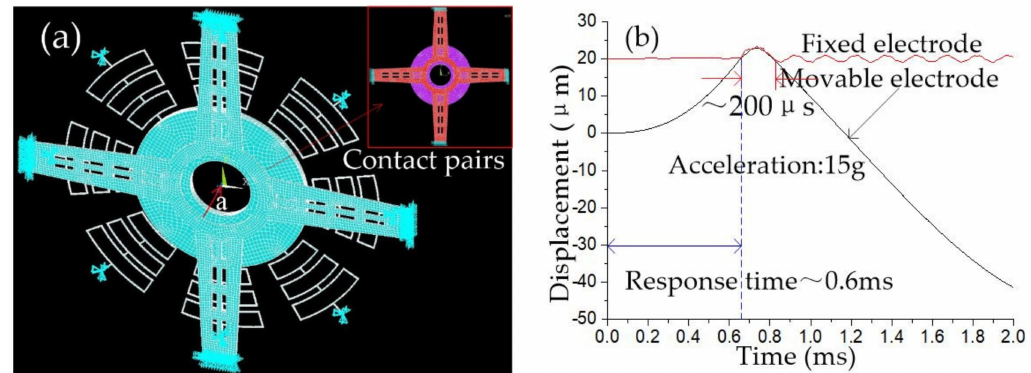
Figure 5. ( a ) The simulation finite element model for dynamic contact in the vertical direction; ( b ) The dynamic response curves of movable and fixed electrodes in the vertical